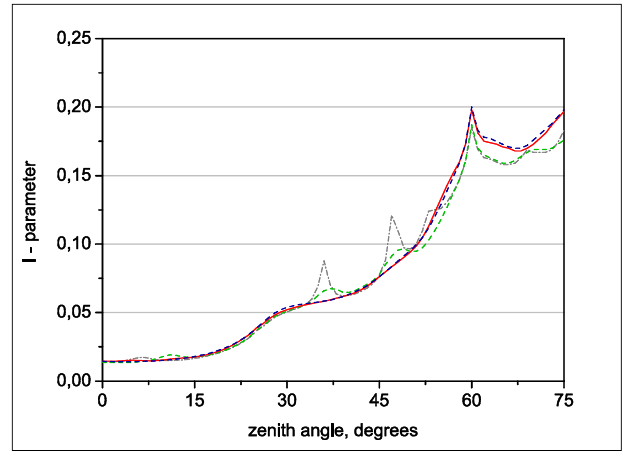
Figure 8. The normalized intensity calculated for the aerosol model. Optical thickness = 0.3262, SZA = 60°, relative azimuth = 180°. Red solid line—benchmark calculations, blue dashed line—calculations using 10 5 photons with the transformed scattering matrix, gray dashed-dotted and green dashed lines—calculations using 10 4 photons with the initial and transformed scattering matrixes, respectively.